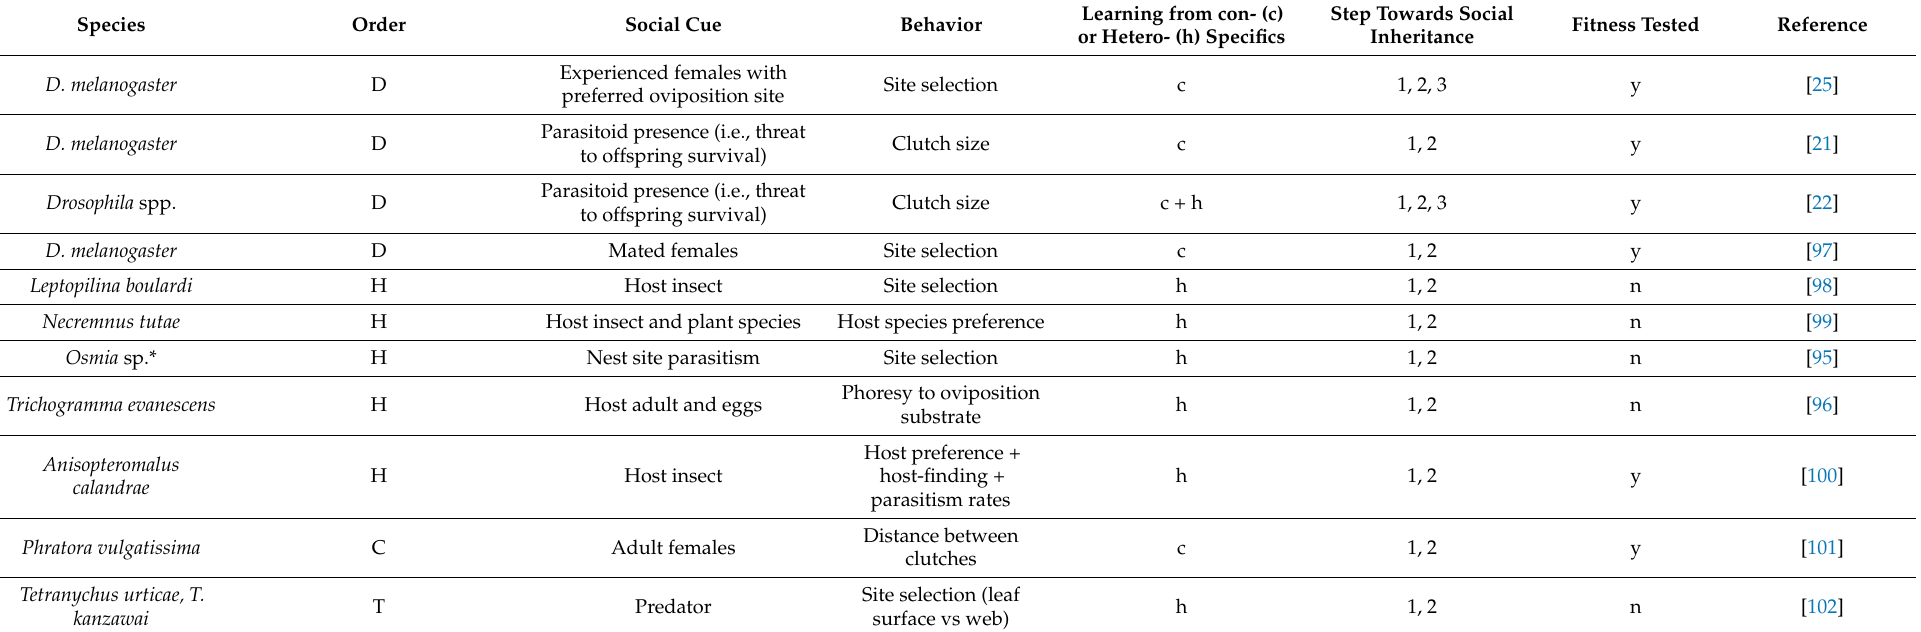
Table 1. List of studies on non-social arthropods where social cue perception, social learning, and transmission of socially learned oviposition-related behaviors was quantified. Only studies that document social learning are included (i.e., from step 2 of Figure 1 onwards), as there is a large body of literature covering cue perception (i.e., step 1 of Figure 1). The table includes the species, the order (Diptera = D, Hymenoptera = H, C = Coleoptera, Trombidiformes = T), the type of social cue and the behavior under study, con- (c) or hetero- (h) specific social learning, the steps towards social inheritance (as in Figure 1) and if effects on fitness were quantified in the study. Studies concerned with foraging, mating, host finding and other behaviors, including in non-insect invertebrates, have been discussed elsewhere